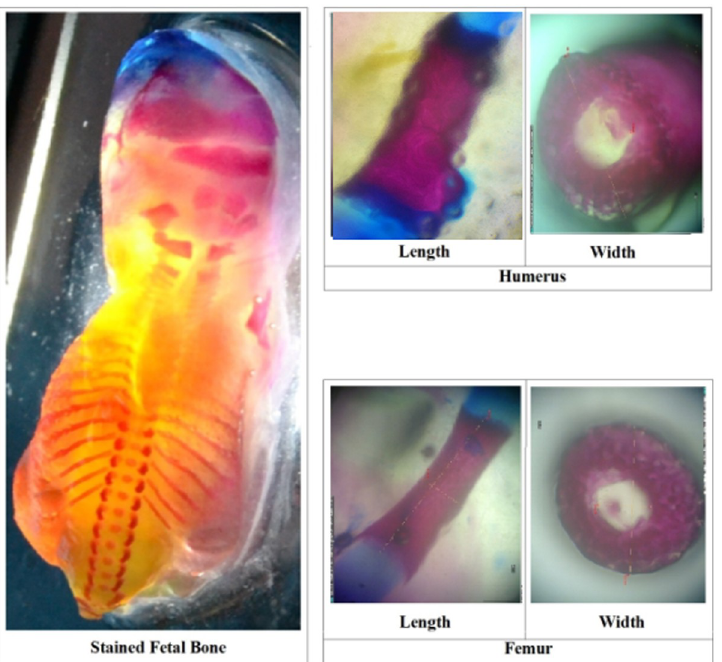
Fig 5. A sample of stained fetal bone with Alizarin Red S and Alcian Blue (the size of these images is disproportionate). The dorsal stained fetal bones of four groups of experimental animals were observed to determine the number of ossified skulls, vertebrae, and ribs on gestation day (GD)18. The index of length of ossified part (ILOP, growth in length) and index of width of ossified part (IWOP, growth in diameter) of humerus and femur in morphologically normal living fetuses (MNLF) of M . musculus on GD18 were determined according to Fig 2.